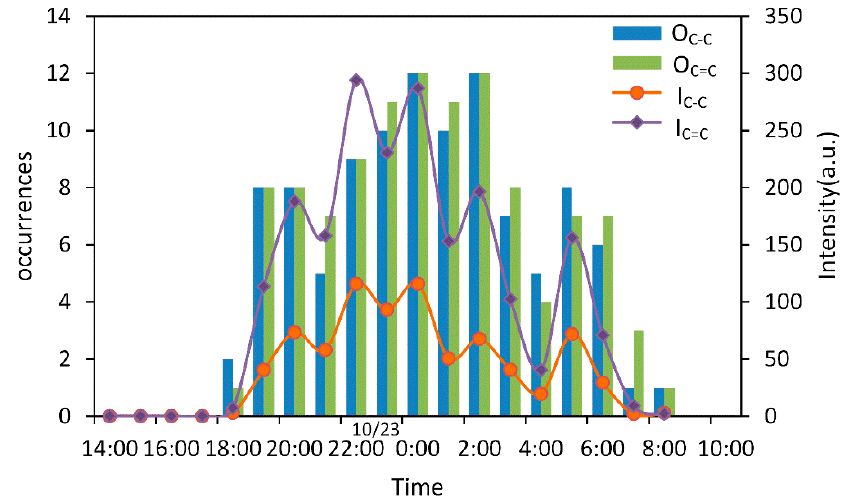
Figure 5. Hourly changes of occurrences and average intensity of carotenoid Raman signals resulted from C–C stretching and C=C stretching. (O C–C , the occurrences of C–C stretching mode; O C=C , the occurrences of C=C stretching mode; I C – C , the average intensity of C–C stretching mode of an hour; I C=C , the average intensity of C=C stretching mode of an hour). Blue and green histogram signify the occurrences detection of C–C stretching at 1157 cm − 1 and C=C stretching mode of β -carotene at 1527 cm − 1 (detection 12 times per hour), respectively. Orange lines and violet points represent average intensity of one hour of all above carotenoids.